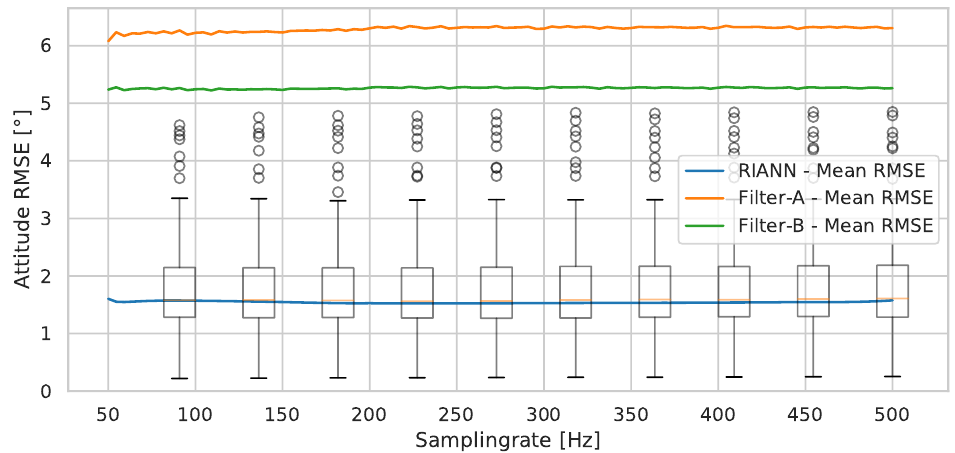
Figure 13. RIANN’s attitude RMSE distribution (over all test sequences from all datasets) plotted over different sampling rates to which all test data is resampled. The most challenging, the realistic scenario , is considered. Performance is consistent in the filters and in RIANN , with the latter achieving consistently smaller